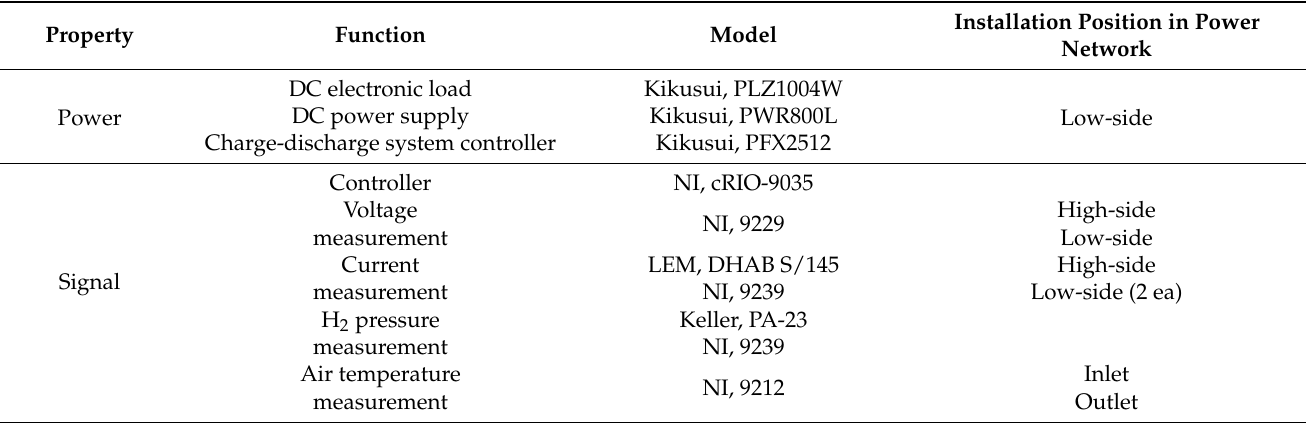
Table 2. Apparatus in unit test